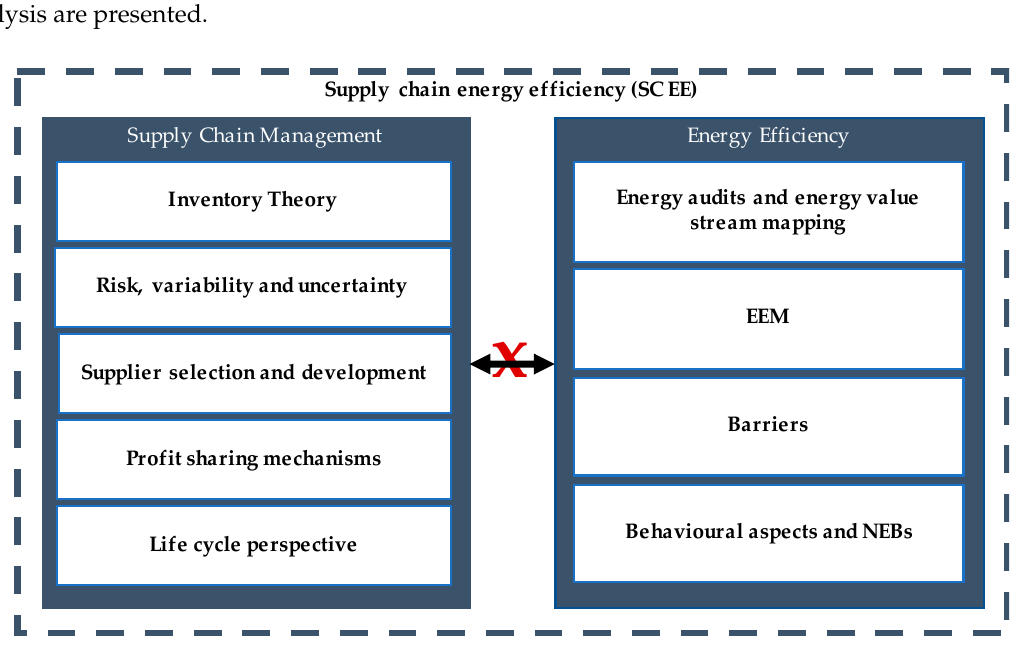
Figure 8. Key themes and subthemes of the literature review.